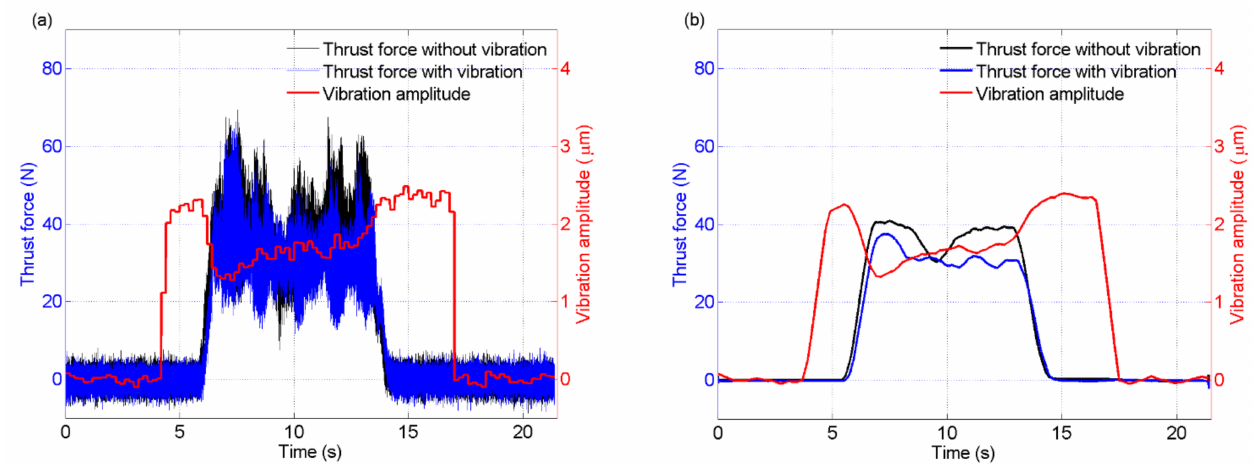
Figure 2. Variations of the thrust force and the vibration amplitude in UVD. ( a ) Raw data; ( b ) smoothed